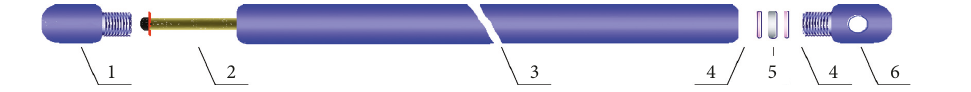
2 fracturing device: (1) filling valve; (2) fever tube; (3) chief tube; (4) seal; (5) shear